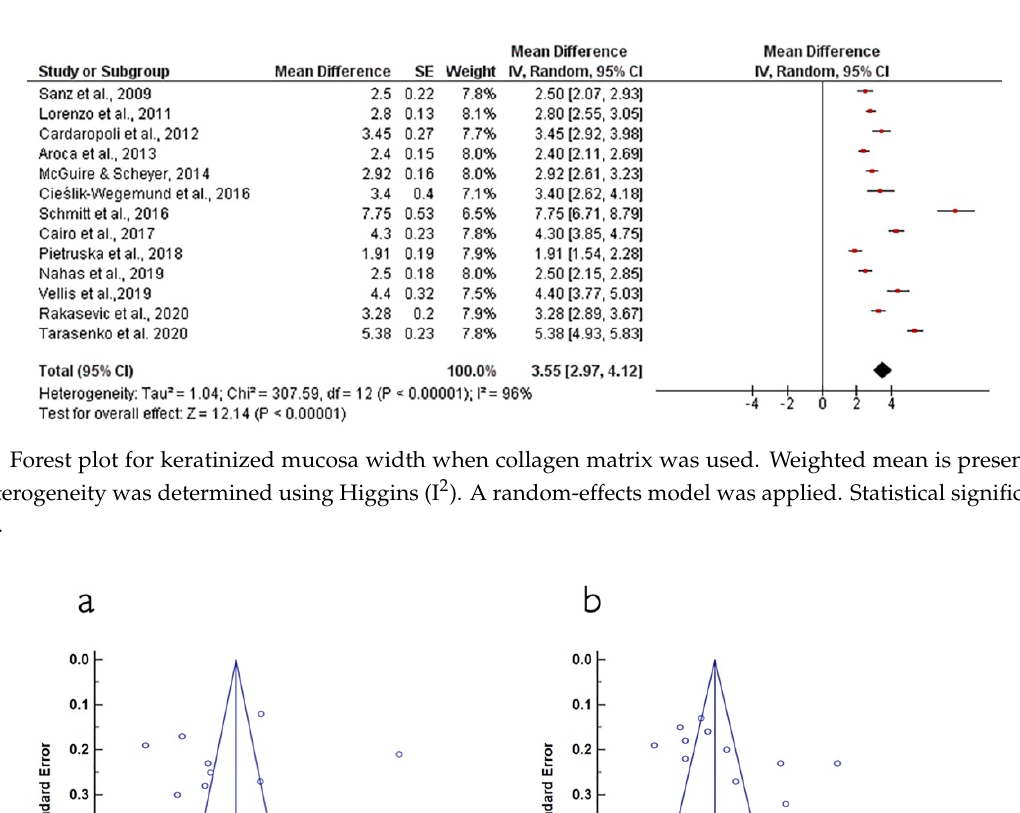
Figure 5. Forest plot for keratinized mucosa width when using autogenous connective tissue. Weighted mean is presented at CI 95%. Heterogeneity was determined using Higgins (I 2 ). A ran- dom-effects model was applied. Statistical significance was p < 0.001.